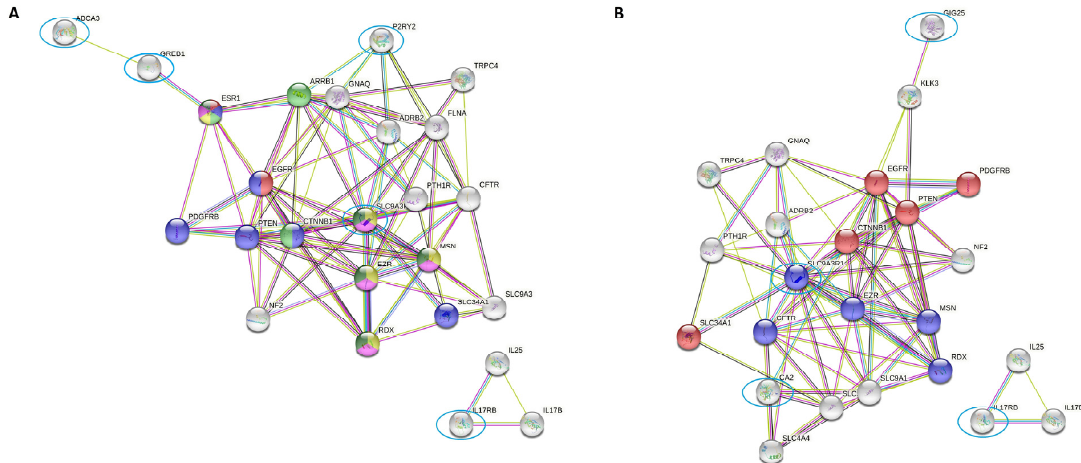
Figure 2. Network of interactions among the differentially expressed genes related to ( A ) “Estrogen Response Early” and ( B ) “Estrogen Response Late” by STRING software. The colored balls represent proteins related to the estrogen pathway. Downregulated genes are marked with blue circles. Associations were visualized with a medium confidence cutoff (0.400).